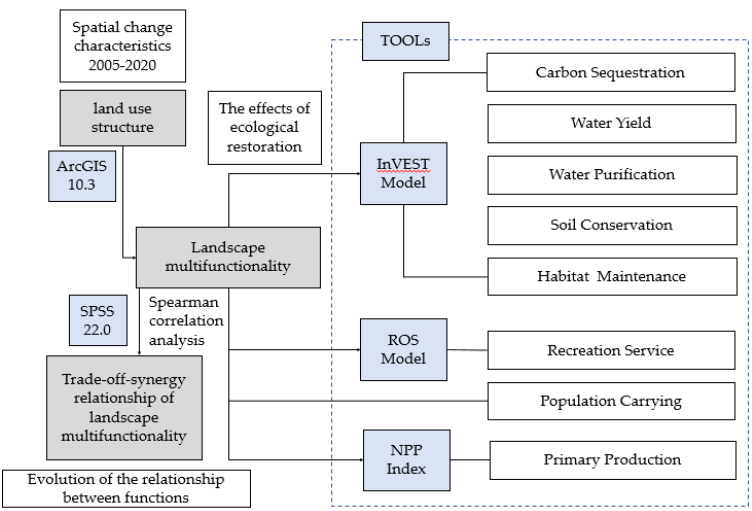
Figure 2. The logical map of the research method.